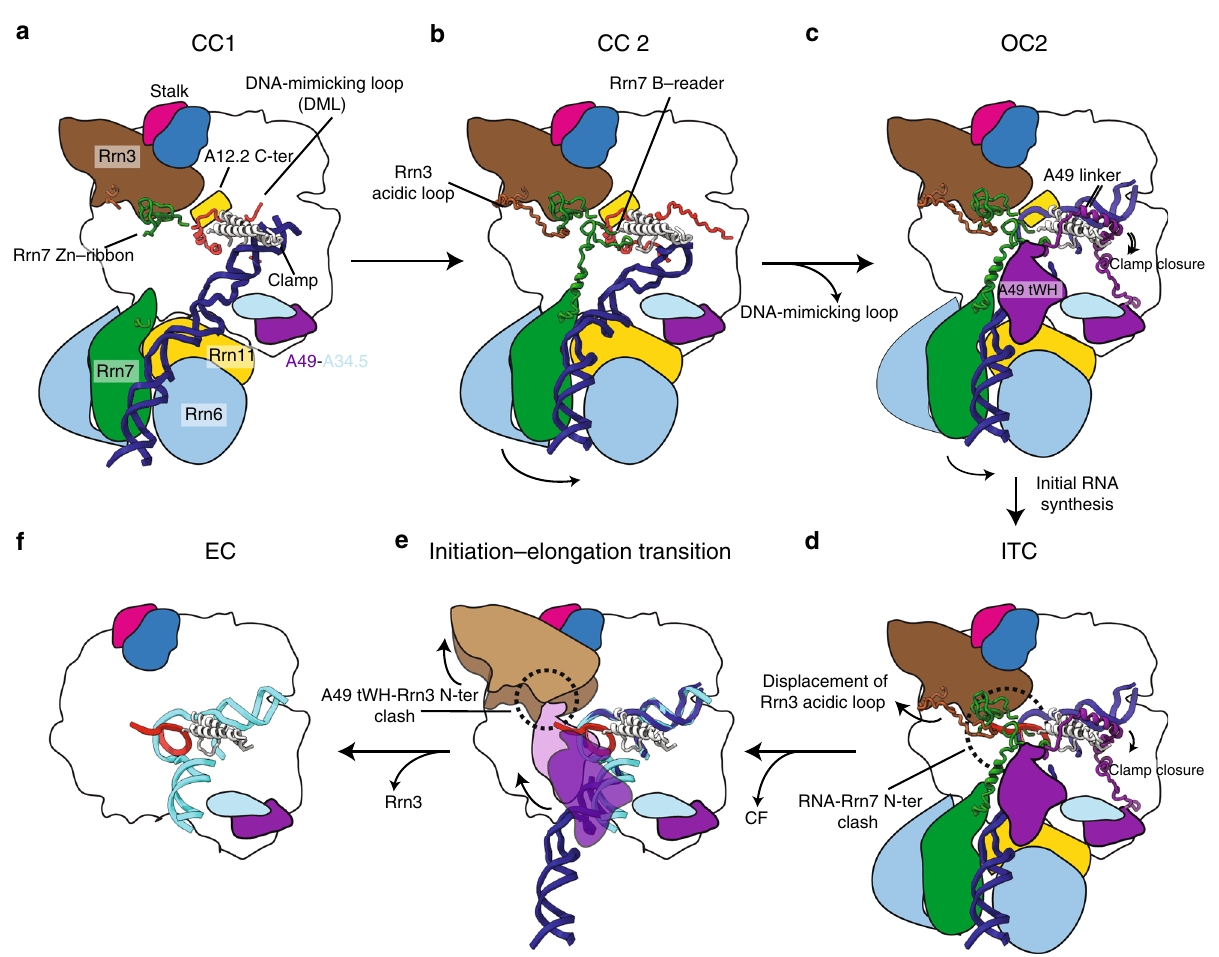
Fig. 6 Mechanism of Pol I transcription initiation and promoter escape. Different Pol I transcription states are depicted as cartoon representation of the corresponding structures. Pol I is depicted as a black contour, A12.2 C-terminal domain as a yellow rectangle and the elements involved in the regulation of initiation and transition to elongation are shown in ribbon. In Pol I CC1 ( a ), the CF is bound to upstream DNA in a distal position from Pol I-Rrn3. At this stage, the B- fi nger of Rrn7 and the acidic loop of Rrn3 are not yet resolved, the cleft is open and the DNA-mimicking loop (red) is present in the active site. Pol I CC1 then transitions to Pol I CC2 ( b ) where CF-upstream DNA rotates with respect to Pol I-Rrn3 in a position closer to its corresponding position in the OC. The acidic loop of Rrn3 and the Rrn7 B- fi nger become better ordered and presumably stabilize the complex. During DNA opening, the template strand is loaded into the cleft and replaces the DNA-mimicking loop while CF-upstream DNA still rotate slightly to form the OC. Once the clamp closes, the A49 linker wraps around the clamp coiled-coil helices and positions the A49 tWH onto the upstream promoter DNA to form the Pol I OC2 ( c ). Together with CF, the A49 tWH recognizes the speci fi city box of the DNA promoter. After initial RNA synthesis, the clamp further closes and the ITC forms ( d ). When the RNA reaches a critical length, it clashes with the Rrn7 B- fi nger, which then displaces the Rrn3 acidic loop. As a result, CF dissociates from the complex. Next, the A49 tWH moves to the EC position where it clashes with Rrn3 and displaces it from the complex ( e ). Finally, RNA synthesis continues and Pol I leaves the promoter and enters the elongation state ( f